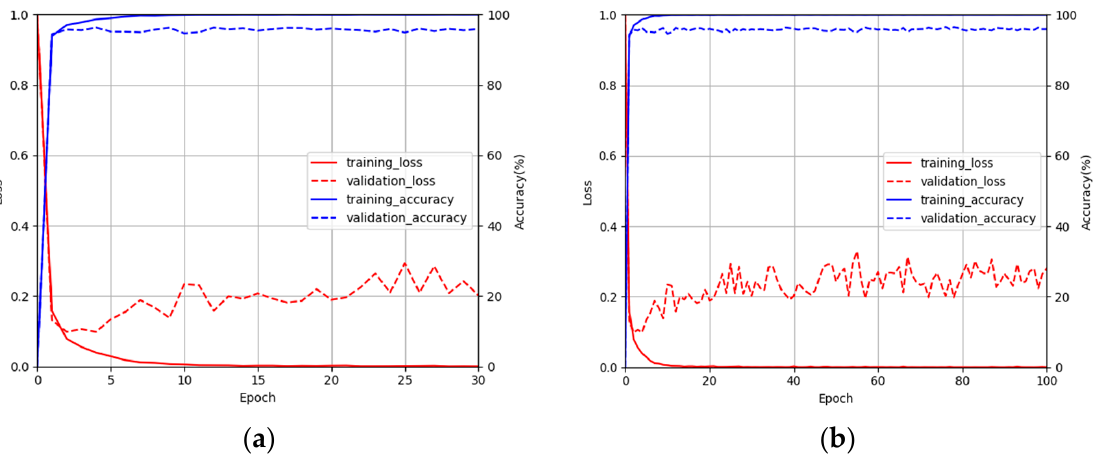
Figure 11. Training and validation loss and accuracy graphs of DenseNet-161 using images restored by the proposed RMOBF-Net: ( a ) trained until 30 epochs (attached in paper), ( b ) trained until 100 epochs.